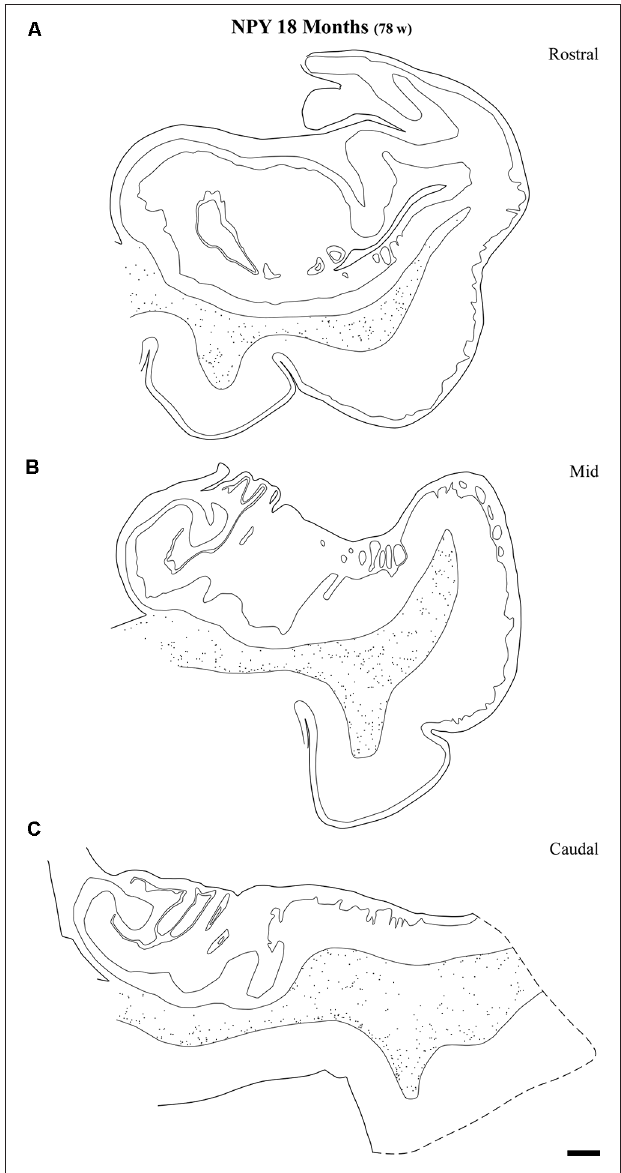
FIGURE 9 | Line drawings of charted NPY-positive neurons at three different rostrocaudal levels of the angular bundle at one and a half years (18 months). While the rostral (A) and mid-level (B) of the series contains a substantial number of labeled neurons, the caudal section (C) shows fewer labeled neurons. Other conventions as in Figure 3 . Scale bar is 2